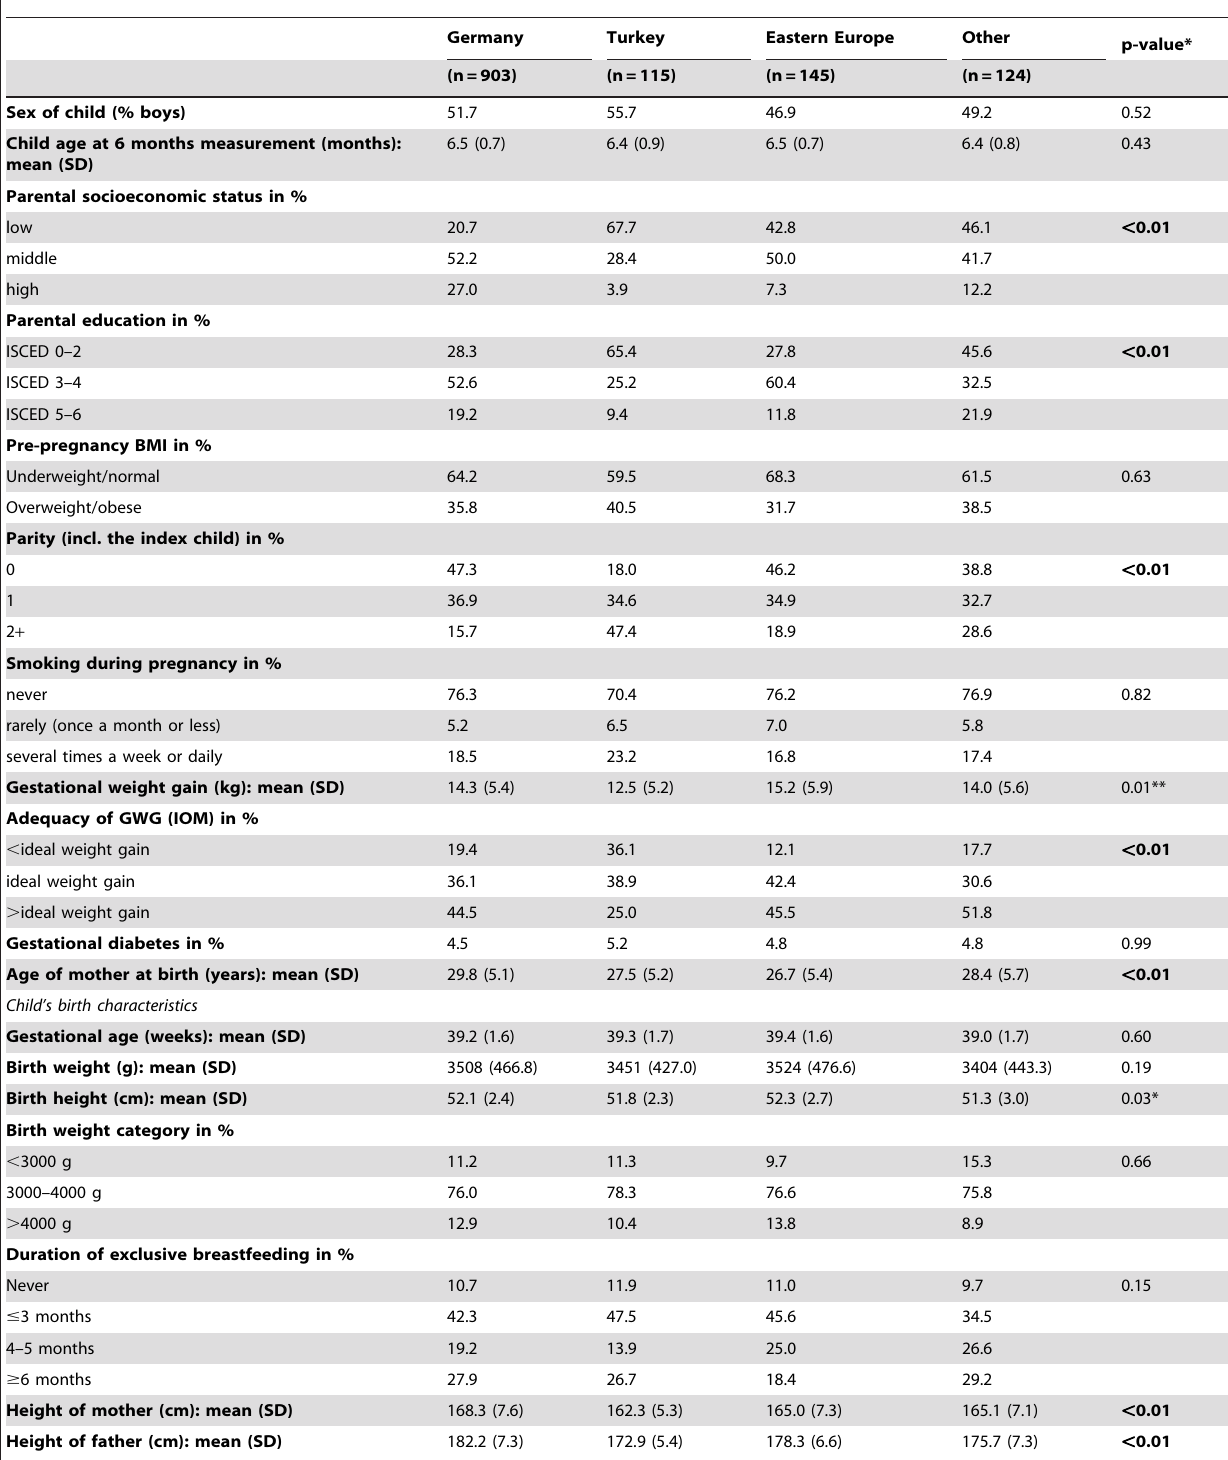
Height of father (cm): mean (SD) 182.2 (7.3) 172.9 (5.4) 178.3 (6.6) 175.7 (7.3) , 0.01 *p-value from global F-Test (ANOVA) for continuous variables, chi-square test for categorical variables. **Scheffe´ test: Gestational weight gain differs between Turkey and Eastern Europe (p , 0.05). Birth height differs between Eastern Europe and Other (p , 0.05). Age of mother at birth different for all migrant groups compared to Germans (p ,